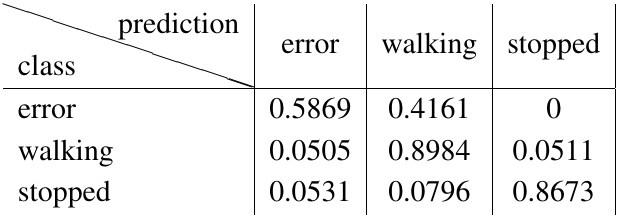
Table 5. Relative Confusion matrix for the HMM generated using BFS to classify the activ- ities walking , stopped and